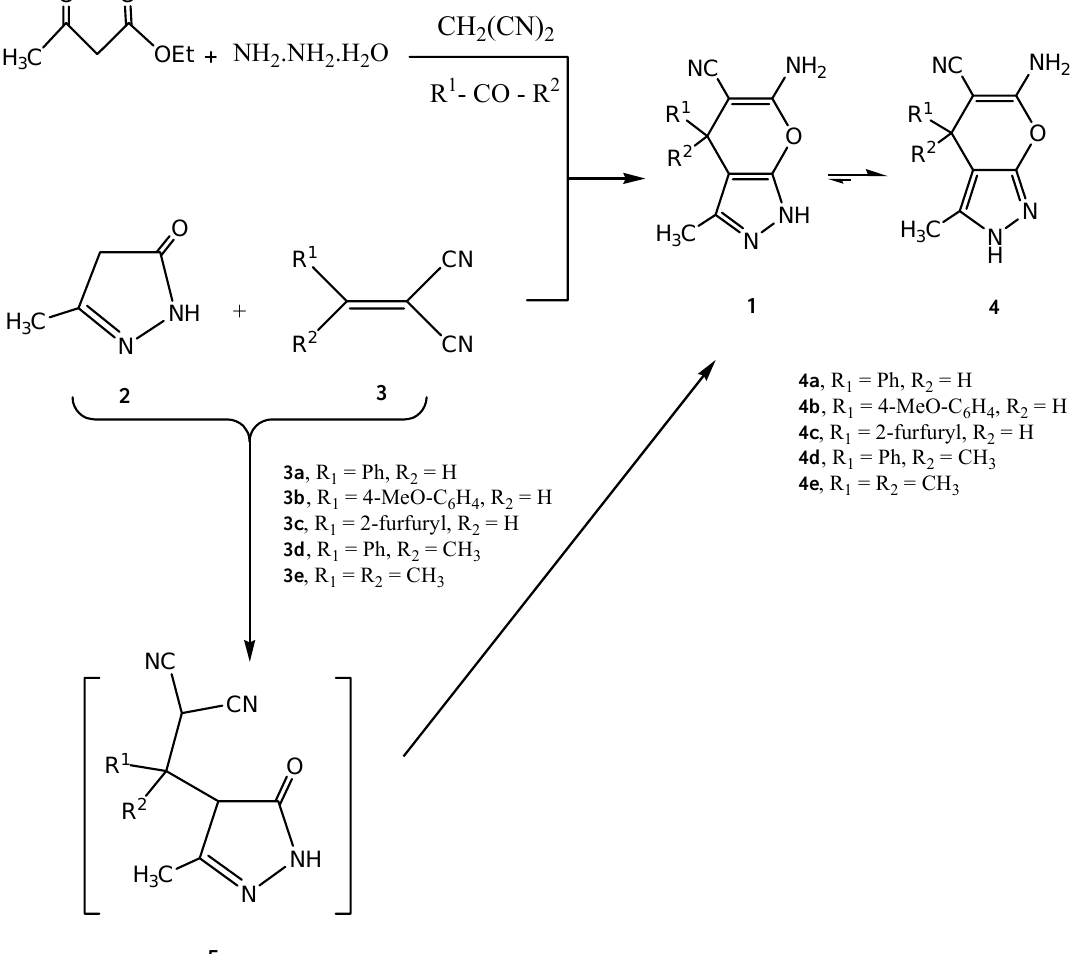
Scheme 1. Proposed mechanism for the formation of 2-H-pyranopyrazoles 4a-e